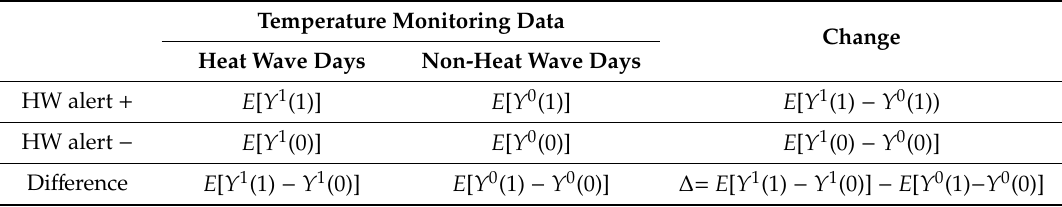
Table 1. Classification of heat wave (HW) days, risk assignments, and definition of Di ff erence-in-Di ff